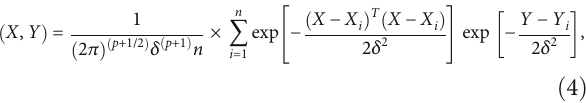
Figure 3: Network training error curve.